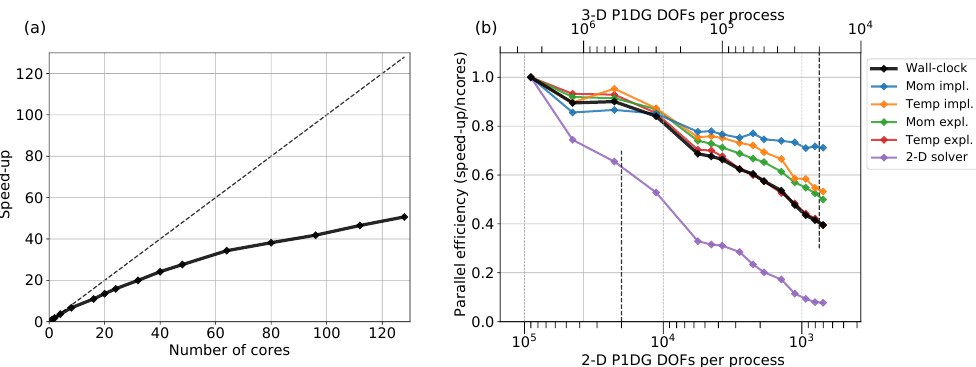
20m 2 s − 1 ): (a) speed-up in wall-clock time versus Figure 7. Strong parallel scaling for the baroclinic eddies test case on a 4km mesh ( ν h = number of processes; (b) parallel efficiency versus the local number of degrees of freedom (DOFs) in the 3-D tracer field (top axis) and the 2-D ( u , η ) mixed system (bottom axis). The black line is the wall-clock time; colored lines stand for the time spent in different implicit or explicit solvers. The vertical dashed lines indicate 20000 DOFs per process for the 2-D and 3-D problems, respectively. The mesh consisted of 10000 triangles, 40 vertical levels, and 400000